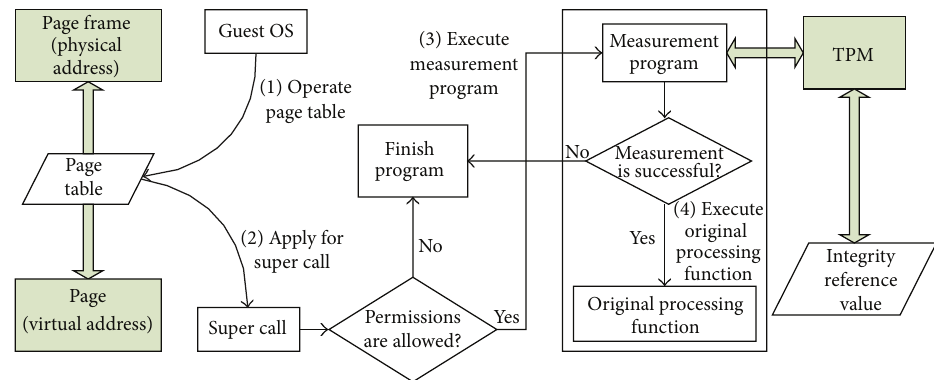
Figure 3: Measurement flow process diagram based on XEN